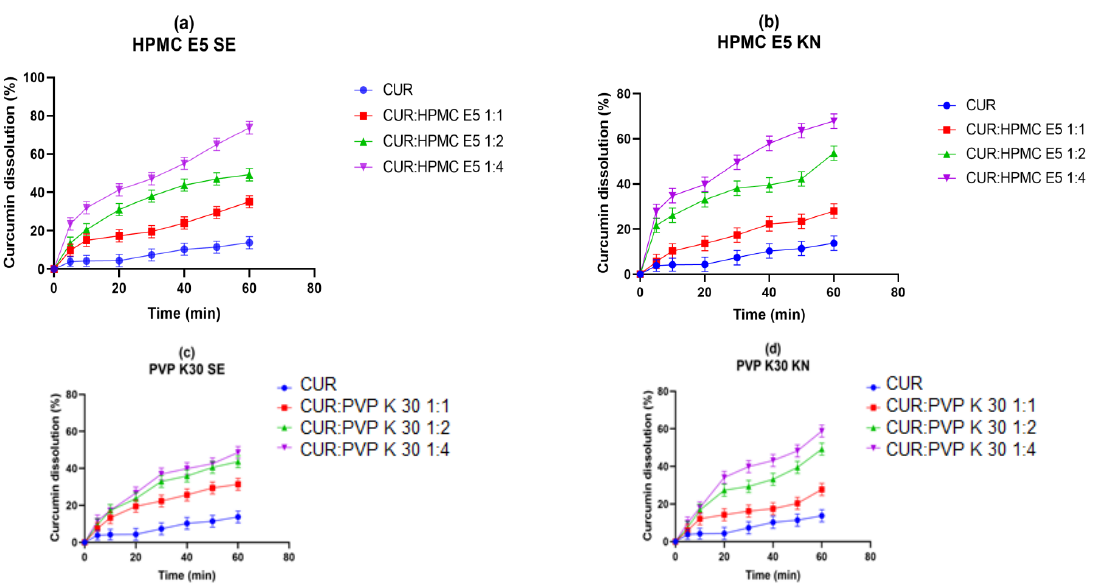
Figure 1. Solubility data of CUR, CUR:PEG 6000, CUR: HPMC E5, CUR:PVP K30, and CUR:BSA by the kneading ( a ) and solvent evaporation ( b ) methods. Mean ± SD, N = 3.